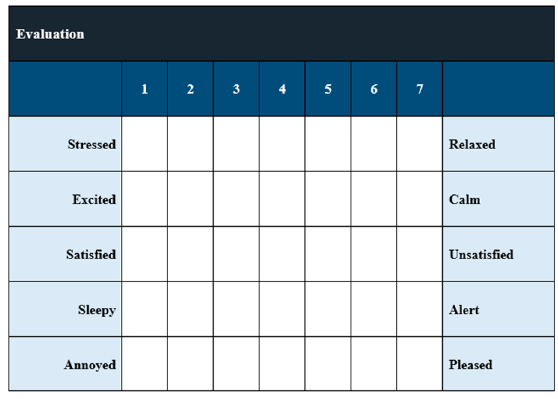
Figure 6. Post-session questionnaire for the evaluation of